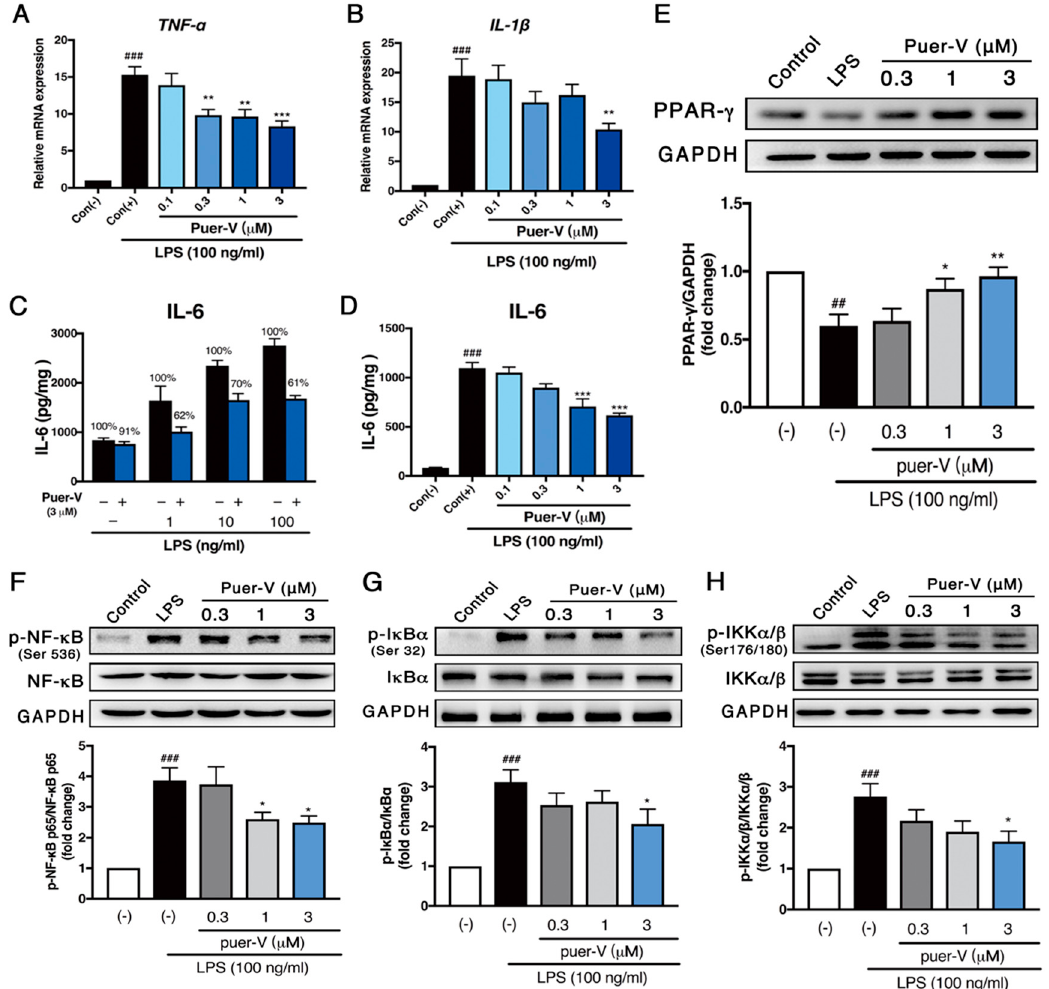
Figure 7. Puerarin-V attenuated LPS-induced inflammation in HCAECs associated with the PPAR- γ /NF- κ B pathway. ( A and B ) The mRNA levels of TNF- α and IL-1 β . ( C ) Confluent cultures of HCAEC were preincubated for 2 h with puerarin-V (3 µ M). Thereafter, different concentrations of LPS were added and cells were cultivated for 24 h. The black bars show the cultures without puerarin-V treatment; the blue bars show the puerarin-V treated cultures. ( D ) Confluent cultures of HCAEC were preincubated for 2 h with different amounts of puerarin-V ( µ M). Thereafter, LPS (100 ng/ml) was added and cells were cultivated for 24 h. ( E ) PPAR- γ expression. ( F ) p-NF- κ B/NF- κ B expression. ( G ) p-I κ B- α /I κ B- α expression. ( H ) p-IKK α / β /IKK α / β expression. Relative density analysis of the protein bands was shown by the western blot with GAPDH as control. Data are shown as mean ± SEM ( n = 4–6). ## p < 0.01, and ### p < 0.001 vs. control group. * p < 0.05, ** p < 0.01, and *** p < 0.001 vs. model